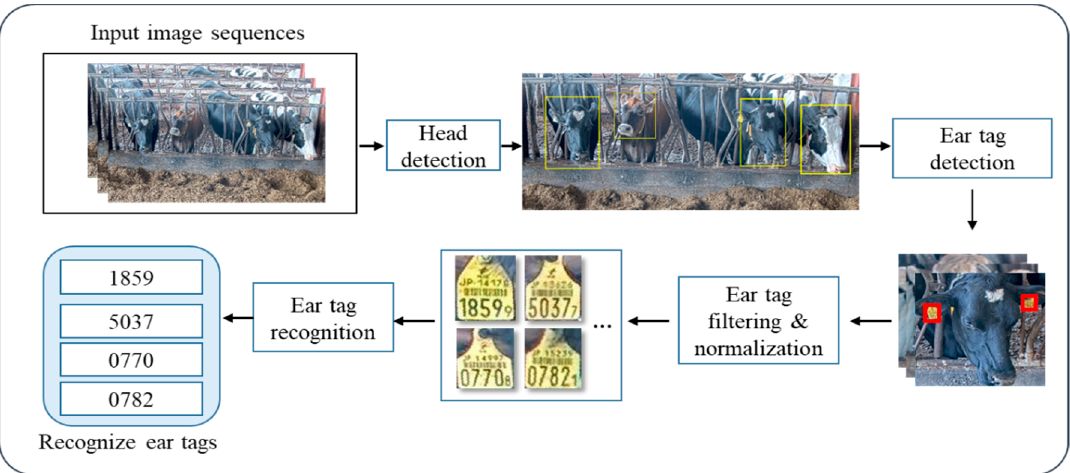
Figure 2. The architecture of the proposed system.